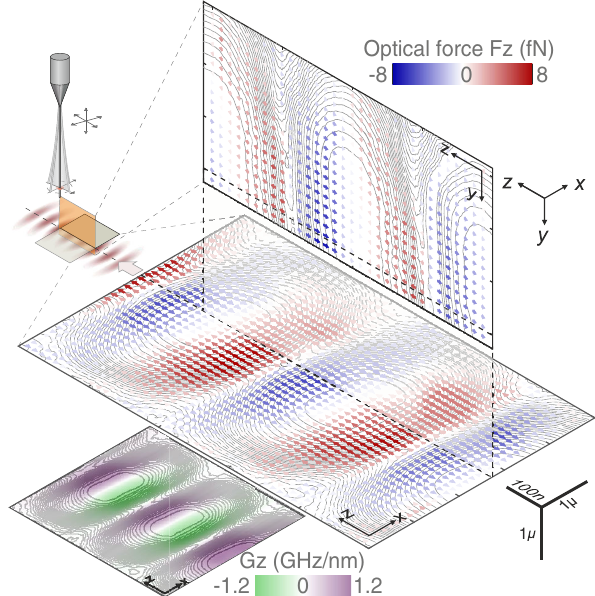
FIG. 4. Nano-optomechanical mapping of the intracavity force field. We show horizontal ( XZ ) and vertical ( YZ ) maps of the intracavity force field (anisotropic length scales), measured for an injected power of 3 μ W at 767 nm. The pump laser is injected along e , and the dashed line represents the optical axis. The color z code indicates the force component along the optical axis F . Inset: z parametric coupling strength G derived from the correction of the z cavity lock. The transmission isovalues are superimposed as gray lines to help visualize the intracavity field